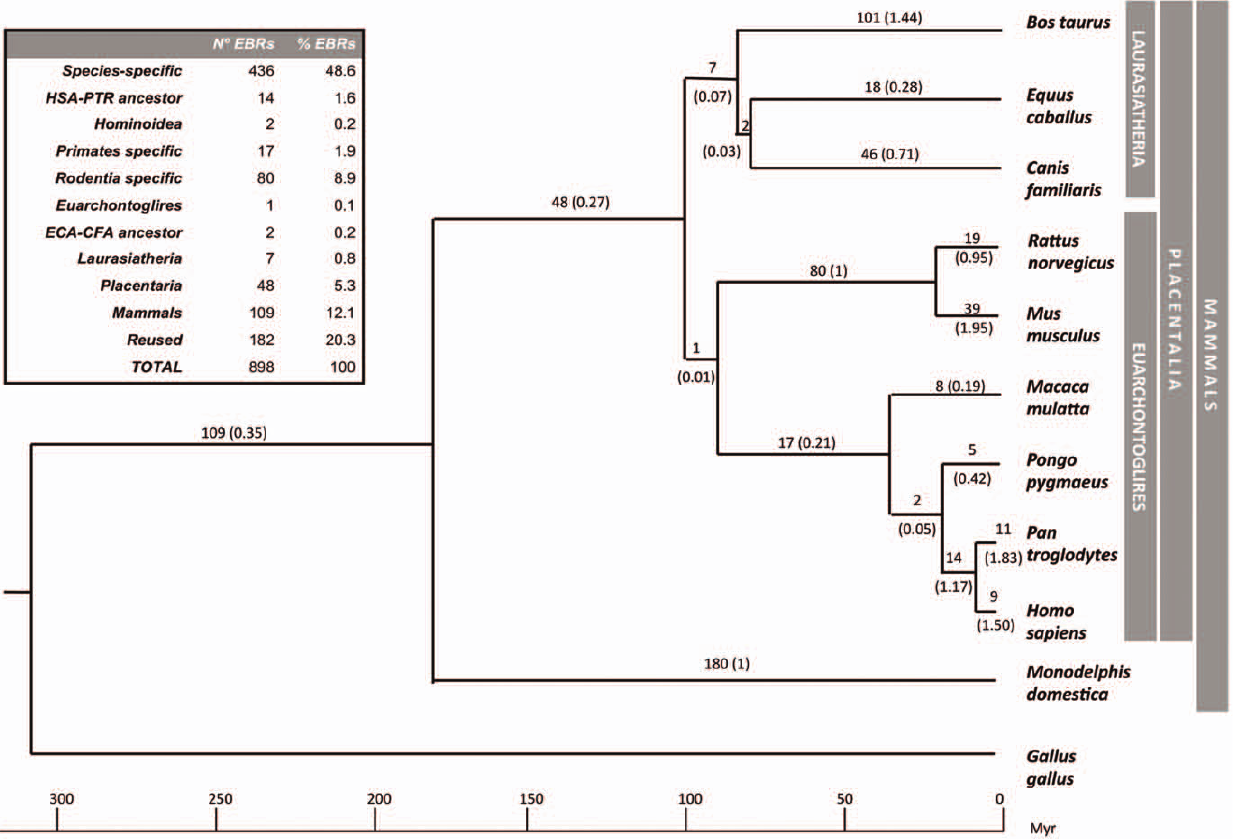
Figure 3. EBRs mapped in the phylogenetic tree of mammalian species included in our study. The phylogeny was based on previous studies [33,62]. The number of specific evolutionary breakpoint regions detected is plotted in each phylogenetic branch. The number of EBRs per million years detected for each lineage is displayed in brackets. Inset shows the number and percentage of EBRs found in our study.